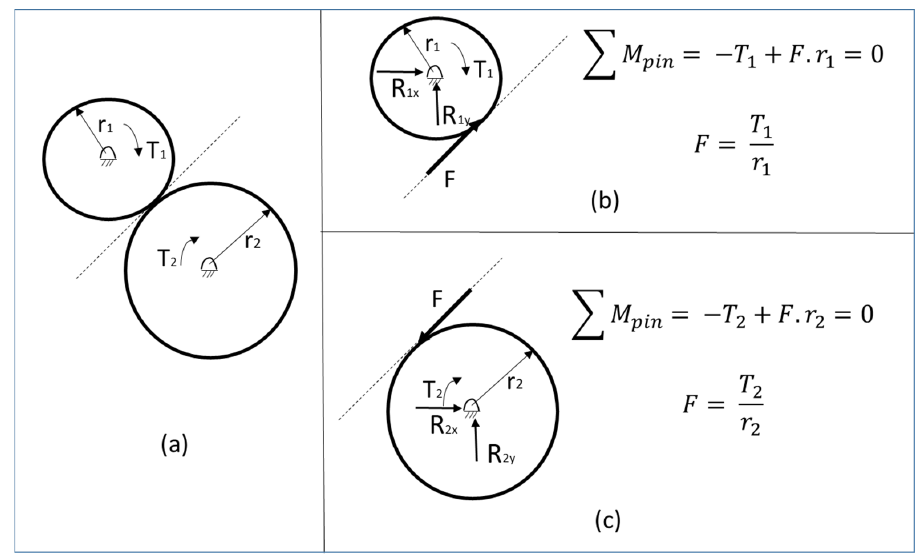
Figure 3. ( a ) Motor and flywheel free body diagram; ( b ) the free body diagram of the motor; and ( c ) the free body diagram of the flywheel.